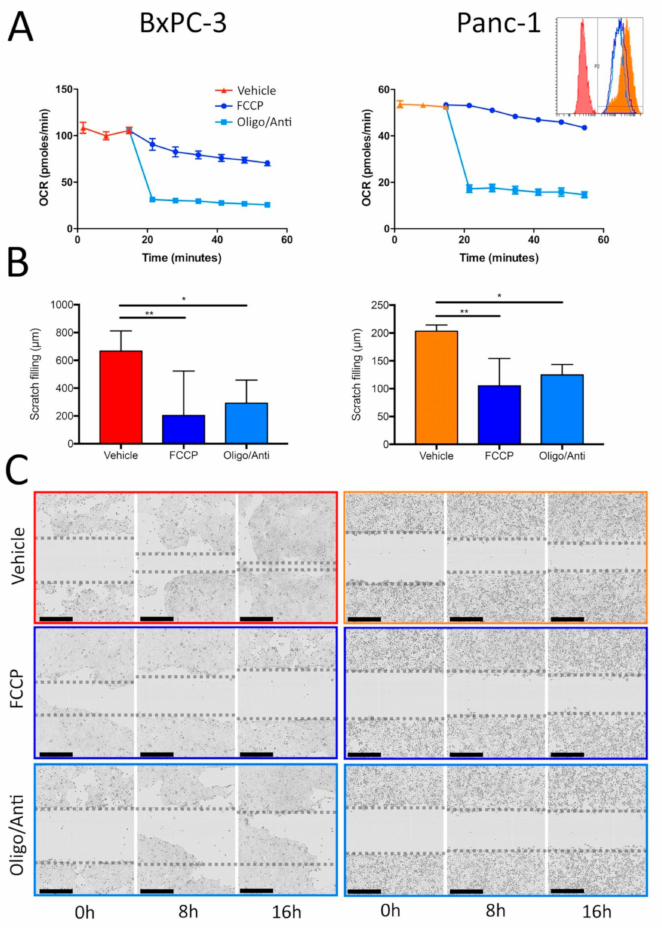
Figure 2. Migration is dependent on oxidative phosphorylation (OXPHOS) in high myoferlin expressing pancreatic ductal adenocarcinoma (PDAC) cell lines. ( A ) Kinetic oxygen consumption rate (OCR) in BxPC-3 and Panc-1 cells before and after treatment with 10 µ M FCCP or 10 µ M oligomycin (Oligo) + 1 µ M antimycin A (Anti). Panc-1 inset represents mitochondrial membrane potential measurement by tetramethylrhodamine, ethyl ester (TMRE) fluorescence in the same conditions. ( B ) End point (16 h) of two-dimension migration kinetic assay (scratch assay) of BxPC-3 and Panc-1 cell lines after treatment with 10 µ M FCCP or 10 µ M oligomycin (Oligo) + 1 µ M antimycin A (Anti). ( C ) Representative images of two-dimension migration kinetic assay with BxPC-3 and Panc-1 after treatment with FCCP 10 µ M or 10 µ M oligomycin (Oligo) + 1 µ M antimycin A (Anti). One representative experiment out of three is illustrated. Each data point represents mean ± SD, n = 3. ** P < 0.01, * P <